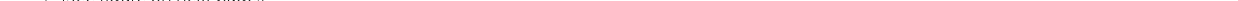
figure on next Fig. 4 Local neutralization of HMGB1 in the mPFC reduced anxiety‑like behaviors and aversion but not pain sensitization after p‑IONX. a Schedule of procedures of mPFC drug delivery experiments in the early phase after p‑IONX. b Schematic (upper) and representative photomicrograph (lower) of the cannula implantation in bilateral mPFC for local infusion of agents. Dashed lines indicate the trace of implanted canula. Scale bar, 100 μm. c Paw withdrawal thresholds to mechanical stimulation and noxious heat stimulation at the left hind paw and head withdrawal threshold to noxious heat stimulation at the left vibrissal pad before and after p‑IONX. *, ** and *** indicate P < 0.05, 0.01 and 0.001, respectively, compared with the baseline (BL), Kruskal–Wallis test with repeated measures and Dunn’s post hoc . #, ## and ### indicate P < 0.05, 0.01 and 0.001, respectively, compared with the sham mAb group at the same time points, two‑way ANOVA with Bonferroni post hoc . d, e Anxiety‑like behaviors measured by + EPM, LDB and OFT on D8/9 ( d ) and D15/16 ( e ) after p‑IONX, respectively. * indicates P < 0.05, compared with the indicated groups, ordinary one‑way ANOVA with Tukey post hoc . f Schedule (left) and schematic (right) of the experiment procedures for the CPP test. g Representative heat maps in the CPP test. h‑j Time spend by the mice in the control IgG‑ and anti‑HMGB1 mAb‑paired boxes ( h ), preference ( i ) and shift preference ( j ) for the anti‑HMGB1 mAb‑paired box in pre‑ (Pre) and post‑conditioning (Post) phases. *, ** and *** indicate P < 0.05, 0.01 and 0.001, respectively, compared with the indicated groups, unpaired t test. ## indicates P < 0.01, compared with the sham group in ( i ), two‑way ANOVA with Bonferroni post hoc . n =